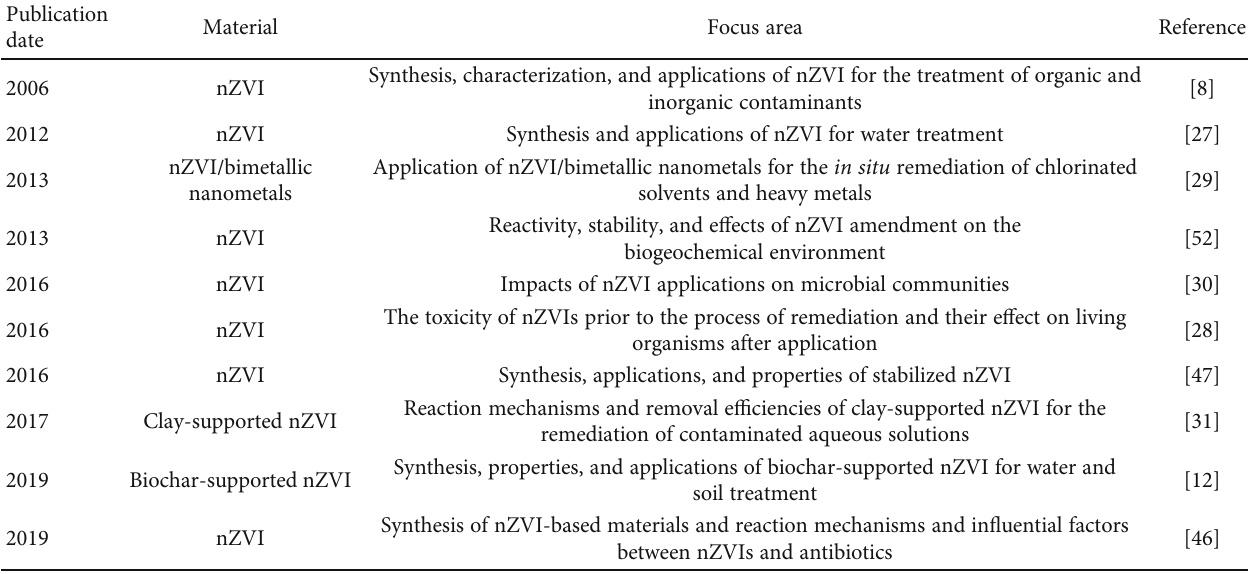
Table 1: Summary of some key review papers on nZVI for water and soil